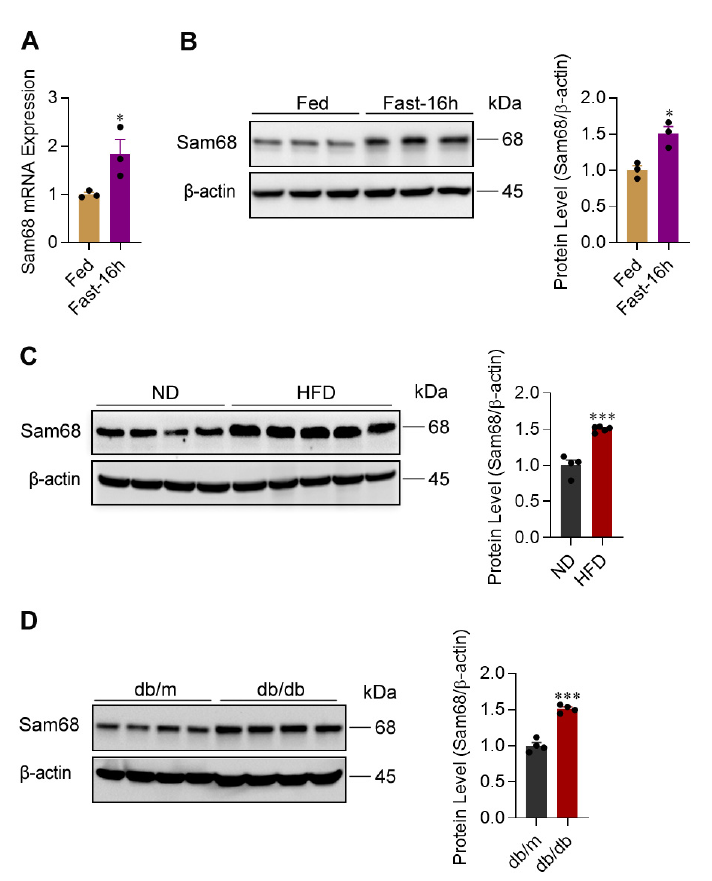
Figure 1. Sam68 is upregulated in the liver of fasting mice, HFD-induced obese and diabetic mice, and db/db diabetic mice. ( A , B ) Sam68 mRNA (qRT-PCR) ( A ) and protein (( B ), left panel, representative Western blot; right panel, quantification) expression were evaluated in the liver of WT mice under feeding condition or after fasting for 16 h. n = 3. ( C , D ) Sam68 protein expression was evaluated in the livers of ( C ) WT mice on normal diet (ND) or HFD for 12 weeks and of ( D ) db/m (control) and db/db mice at age of 8–12 weeks (left panel, representative Western blot; right panel, quantification). n = 4–5. Data are expressed as mean ± s.e.m. * p < 0.05, *** p < 0.001 (unpaired t